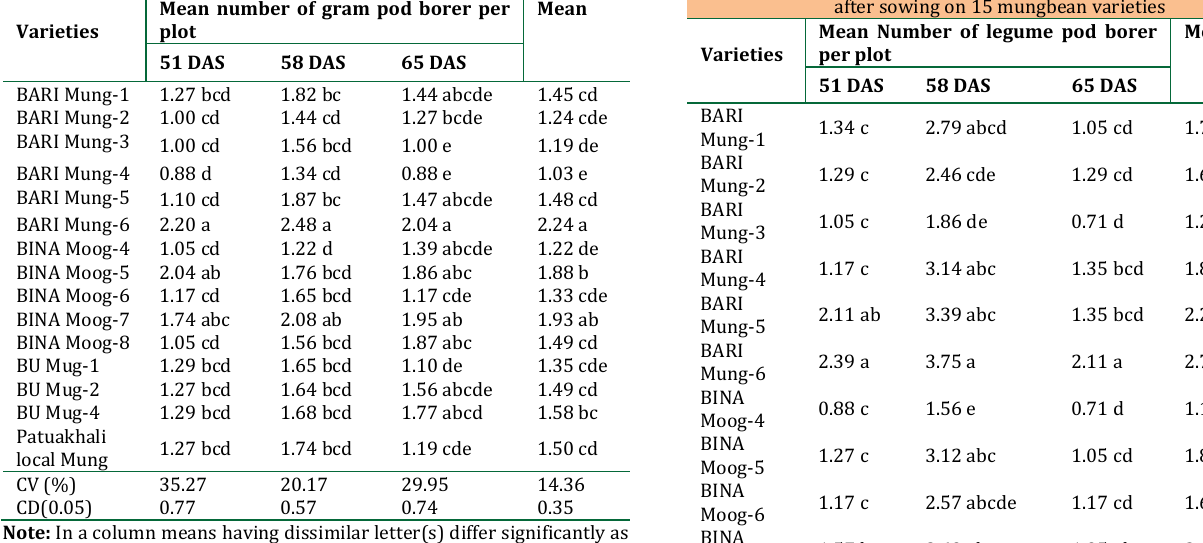
Table 3: Mean number of legume pod borer per plot at different days after sowing on 15 mungbean varieties Mean Mean Number of legume pod borer Varieties per plot 51 DAS